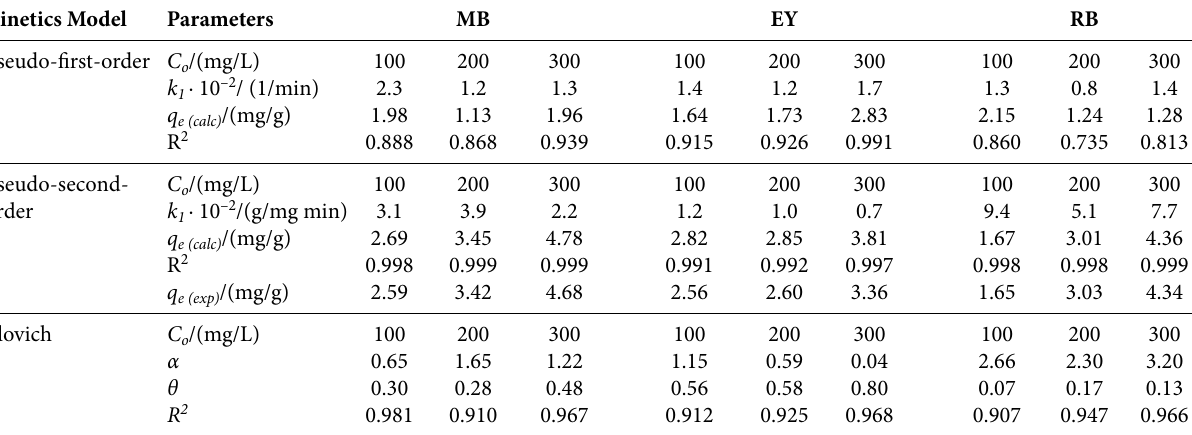
Table 2 . Pseudo-first-order, pseudo-second-order reaction and Elovich kinetics constants for dyes removal on CNAC surface at different initial concentrations. Kinetics Model Parameters MB RB Pseudo-first-order C o /(mg/L)